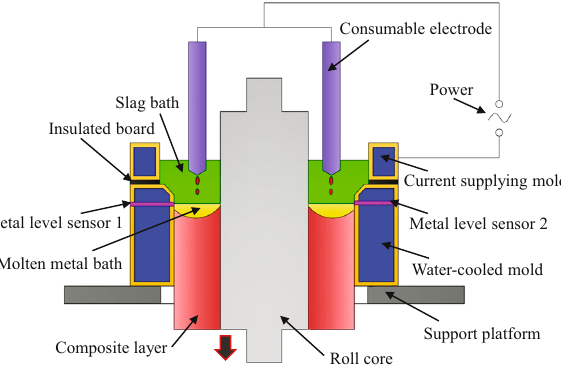
Figure 1: Schematic diagram of the